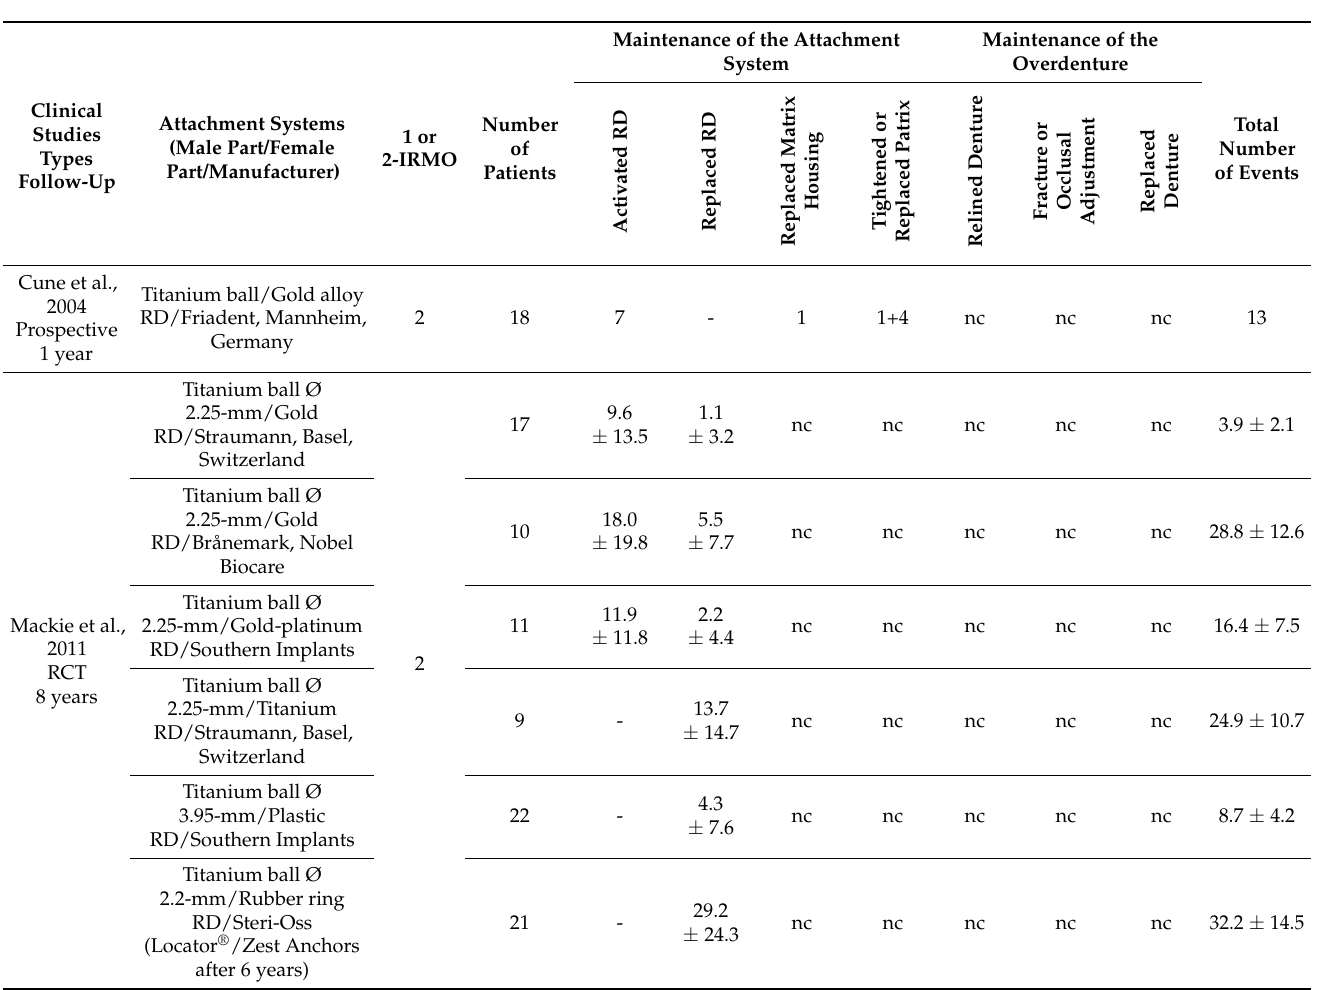
Table 2. Prosthodontic maintenance of 1- or 2-implant-retained mandibular overdentures and their ball or cylindrical attachment systems. Abbreviations: nc, non-communicated; H, hauteur; RD, retention device; RCT, randomized clinical trial, Ø,